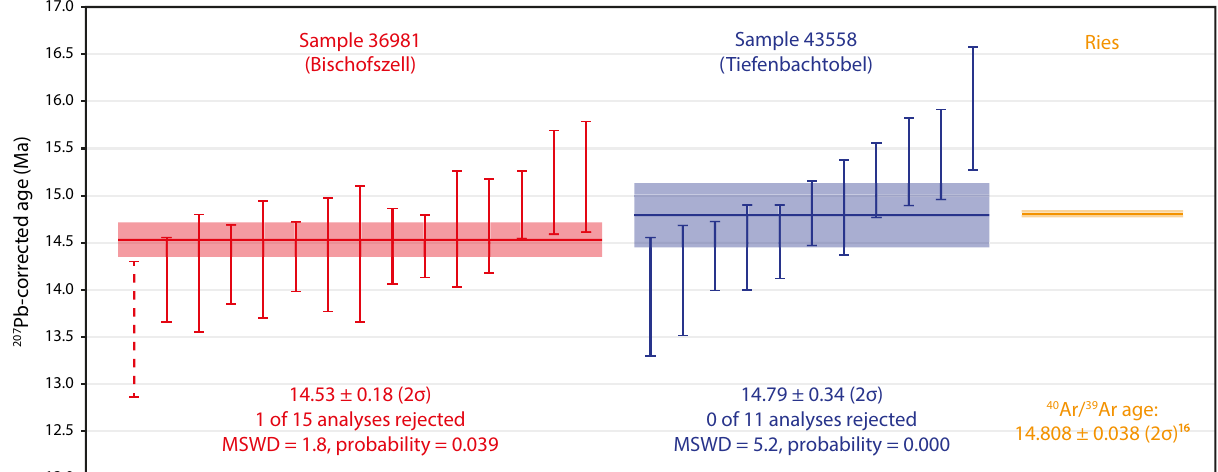
Figure 7. Comparison of results from U–Pb dating of two bentonites (this study) with published 40 Ar/ 39 Ar age 17 for the Ries impact structure. Weighted mean ages were calculated using the Isoplot 4.15 software 40 . MSWD mean square of weighted